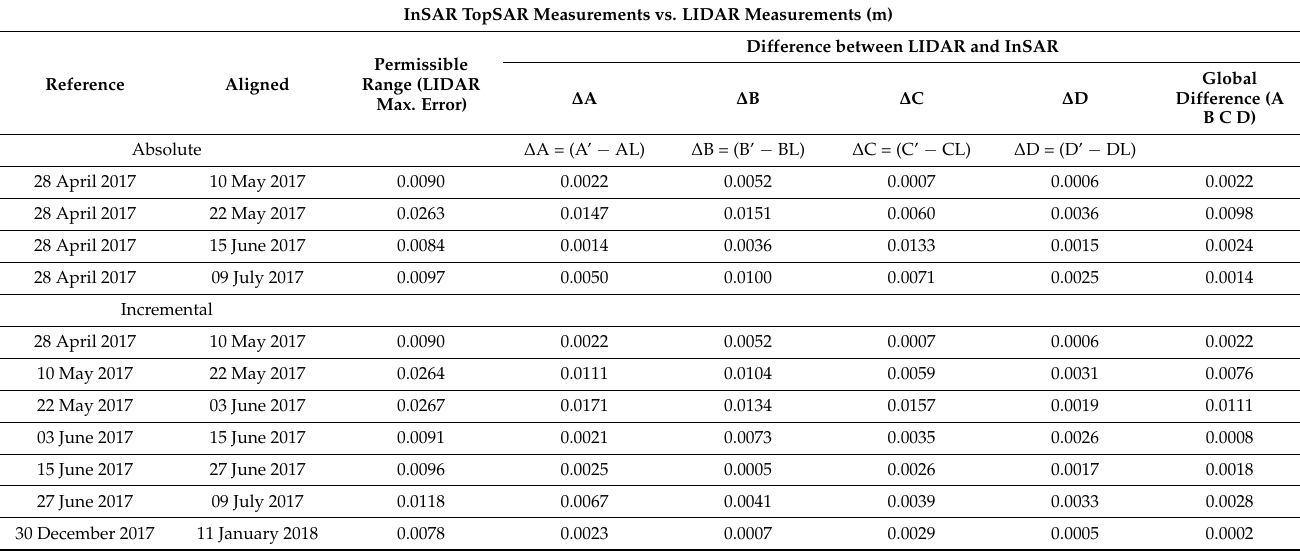
Table 6. Comparison of the results obtained by the two methods. InSAR TopSAR Measurements vs. LIDAR Measurements